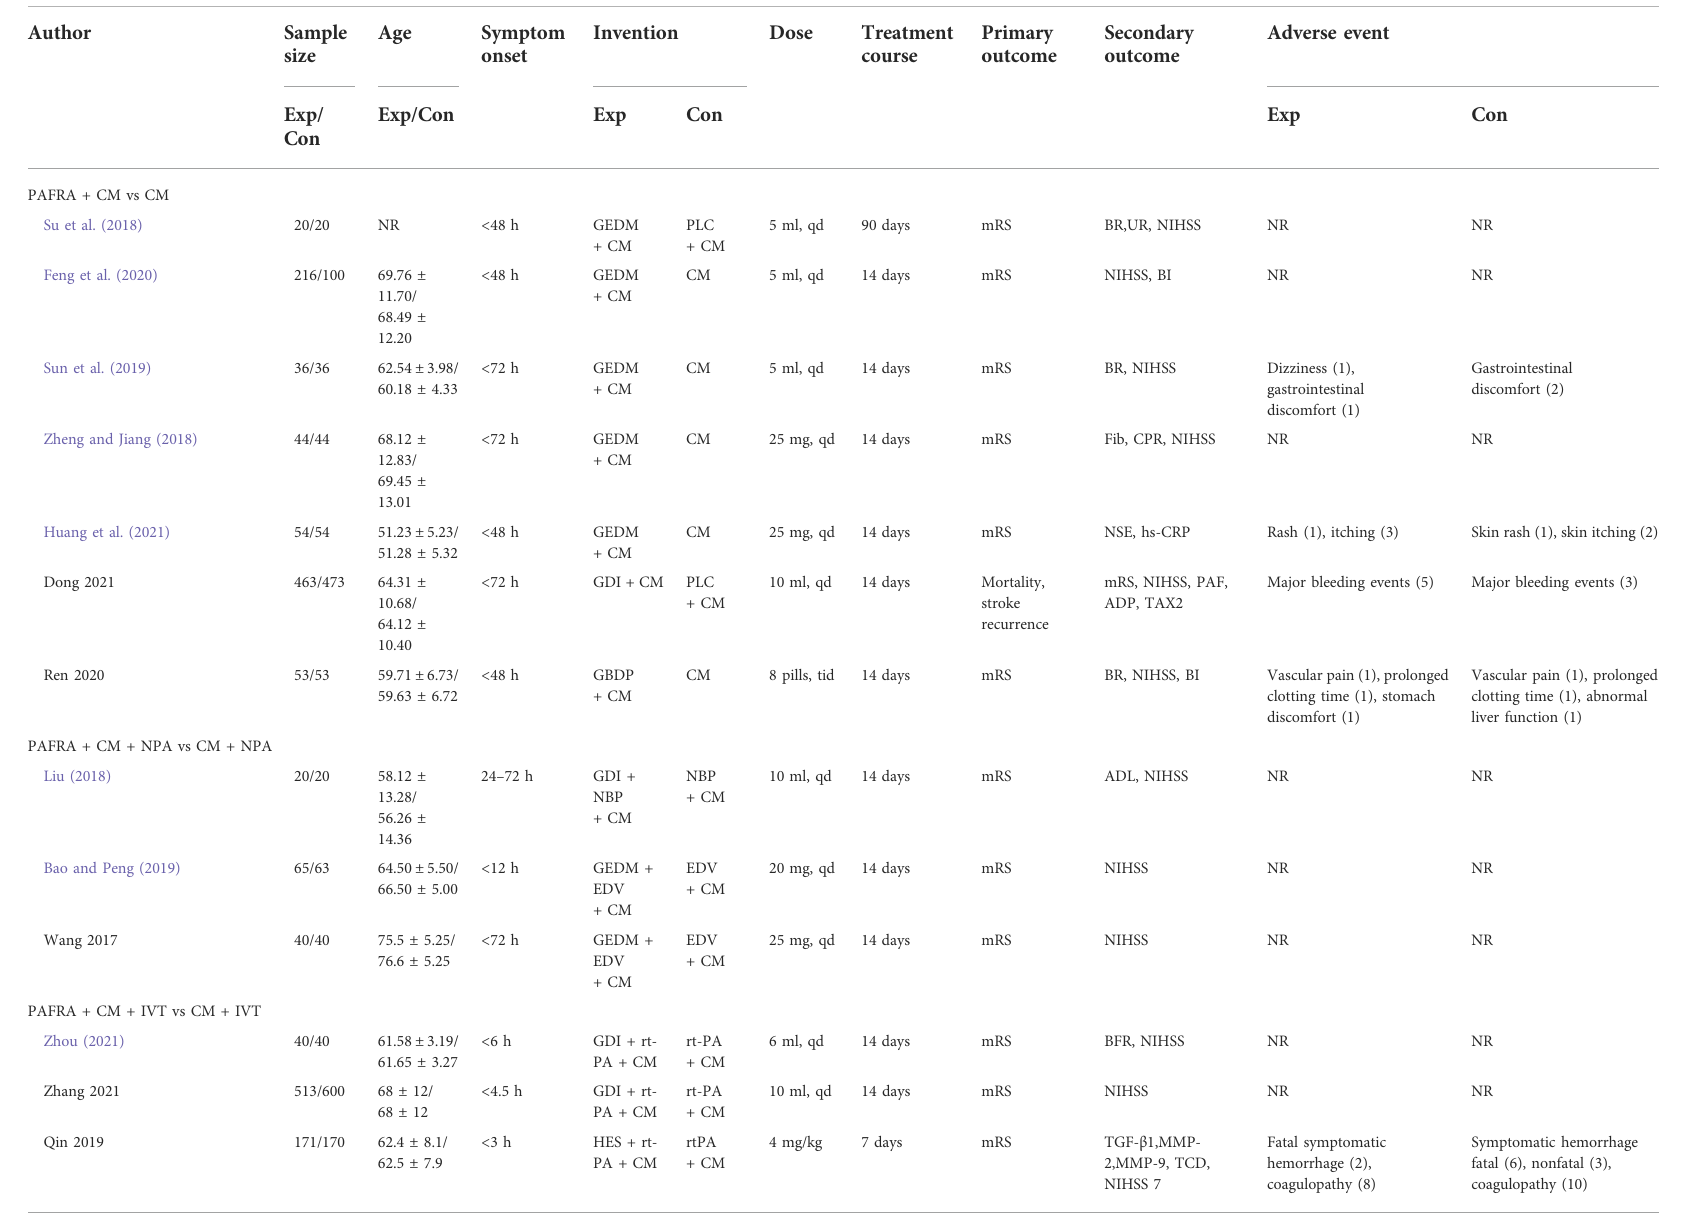
TABLE 1 Overview of randomized controlled trials of platelet activating factor antagonists of natural origin for acute ischemic